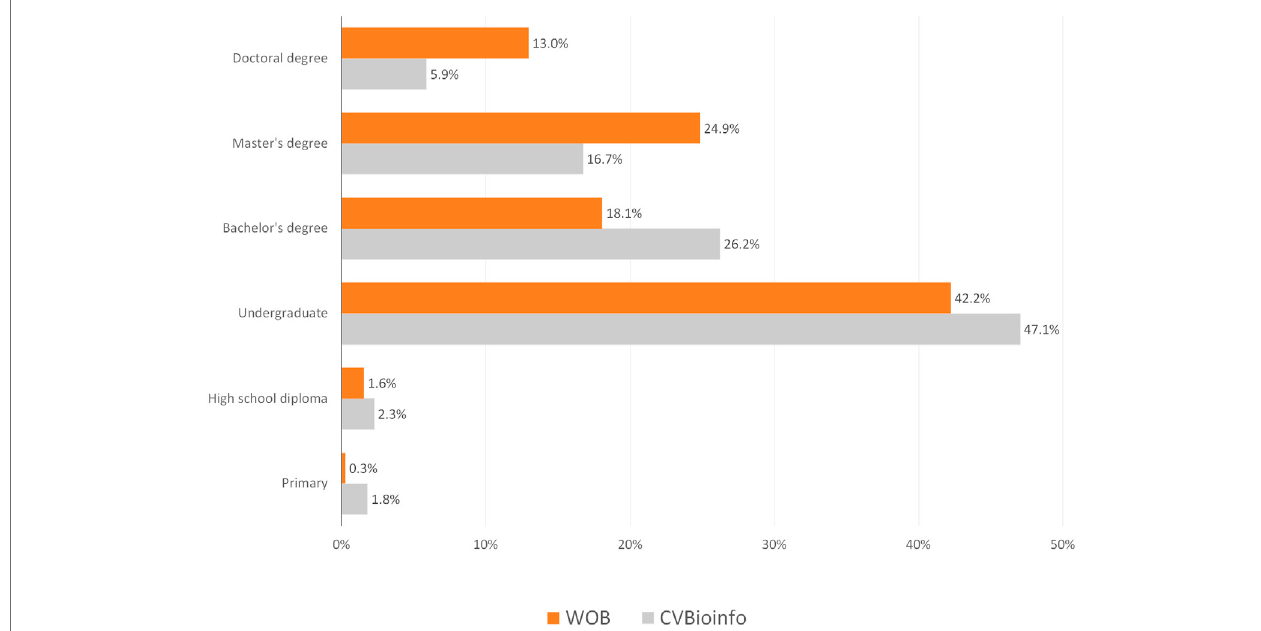
FIGURE 4 | Attendees are grouped by education levels (percentual values). For M.Sc. and Ph.D. degrees, we considered completed or in progress. Total attendees: WOB (cid:1) 2,727; CVBioinfo (cid:1) 221.